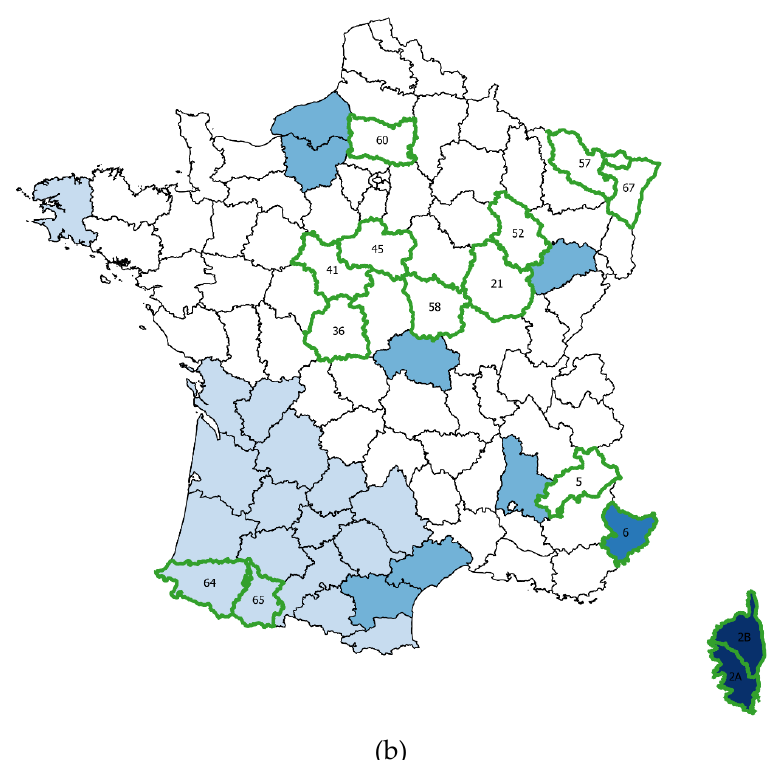
Figure 1. Localization of occurrence of outbreaks in domestic livestock from 2008 up to 2015. ( a ) BTV8; ( b ) BTV1.